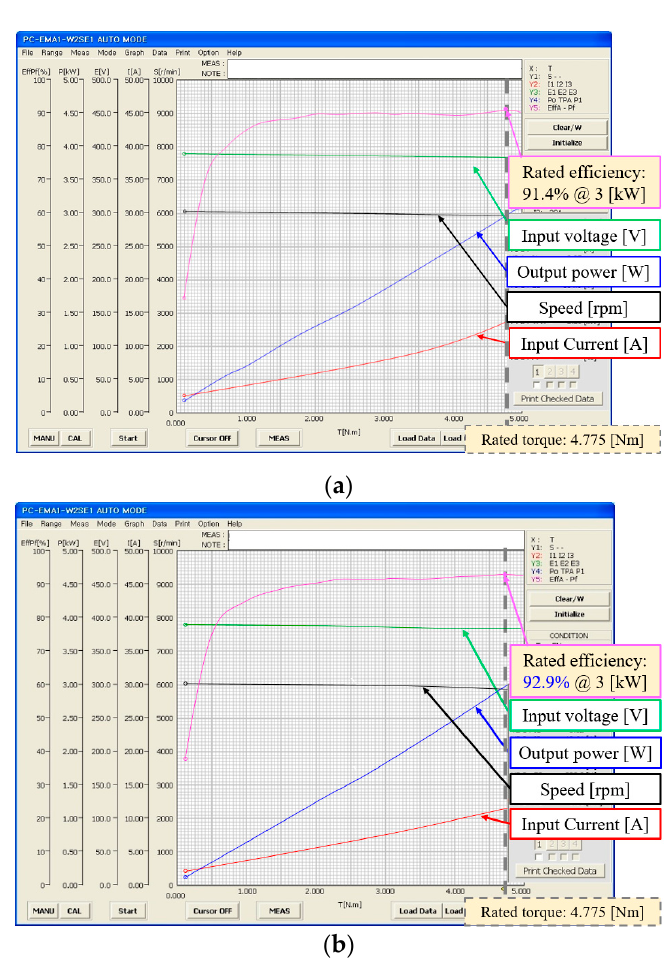
Figure 17. Comparison of experimental motor dynamometer test results: ( a ) Initial model; ( b ) optimal model. Table 4. Simulation and experimental results.